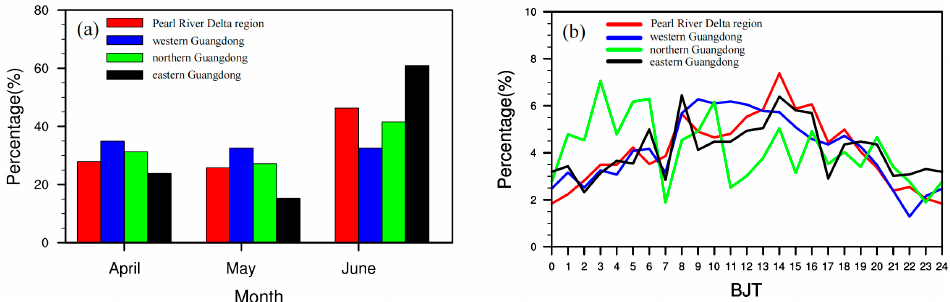
Figure 5. ( a ) Monthly variations and ( b ) diurnal variations of MVs in the four different regions of Guangdong. Red bar (solid line) represents the Pearl River Delta region, with blue bar (solid line) for western Guangdong, green bar (solid line) for northern Guangdong and black bar (solid line) for eastern